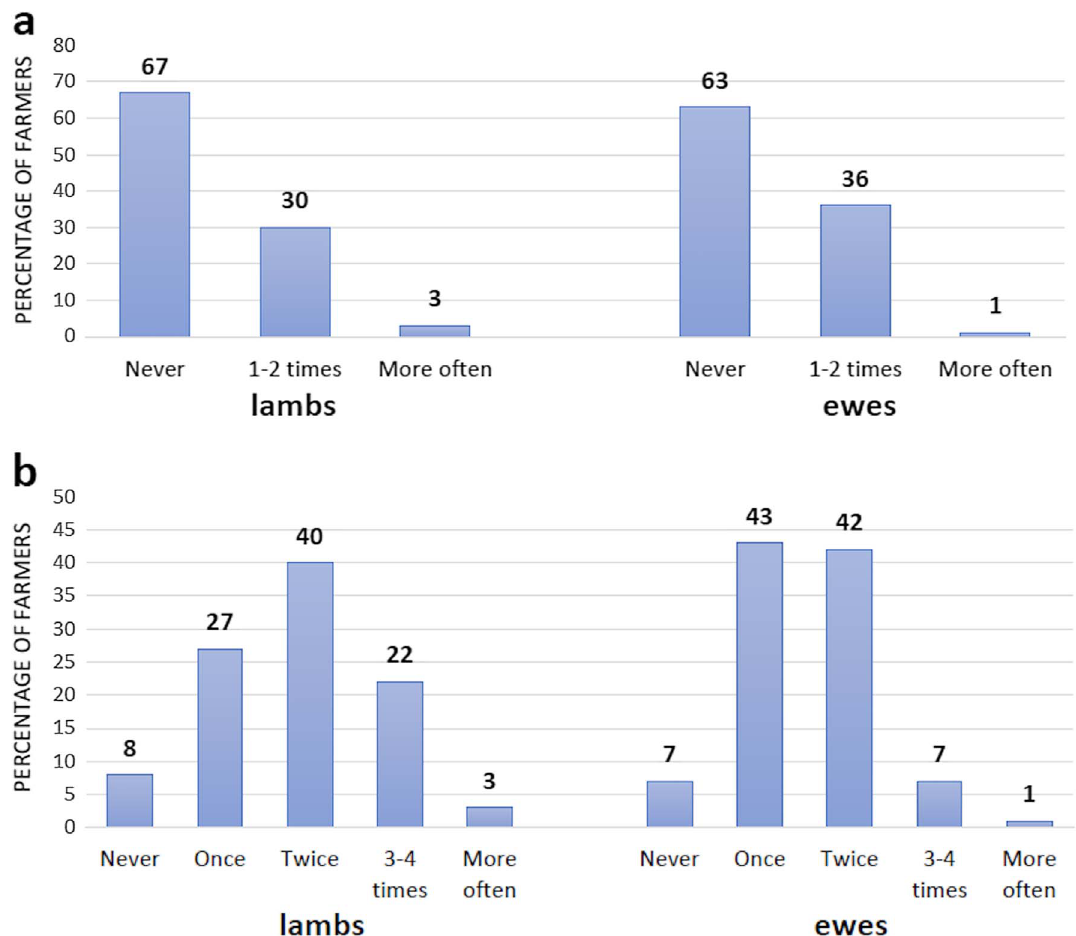
Figure 3. Frequency of treatment against (a) GINs in lambs ( n = 1266) and ewes ( n = 1262), and (b) F. hepatica in lambs ( n = 1270) and ewes ( n = 1293) during 1 year in these fl ocks. Incomplete/ambiguous responses were excluded, thus the n value (number of respondents) varies. Percentages are indicated above the